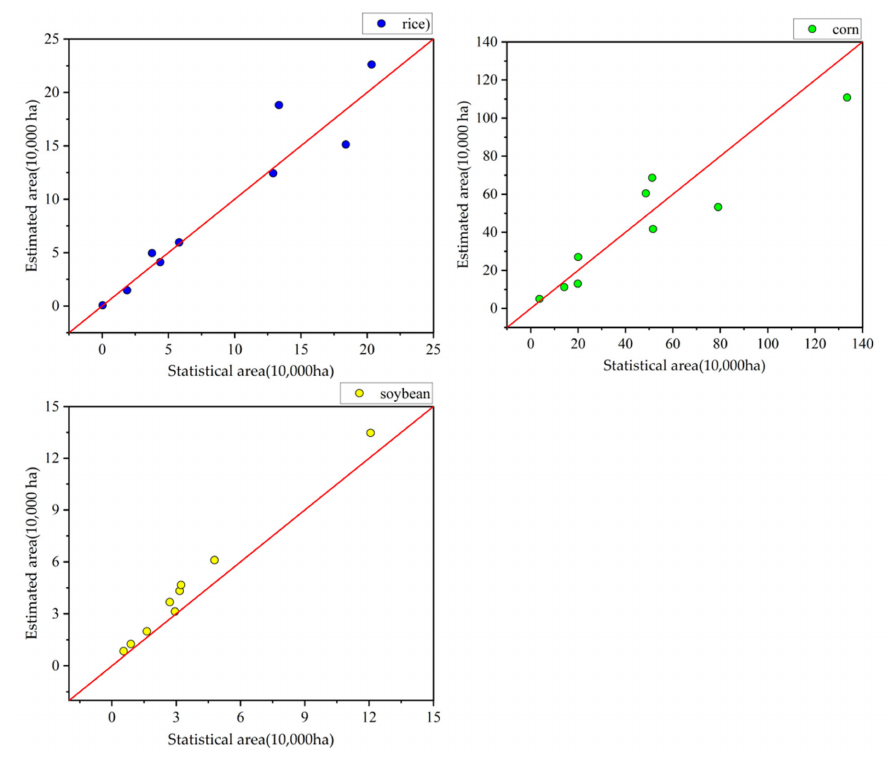
Figure 9. Comparison of the estimated area and the statistical data for rice, corn and soybean in the study area in